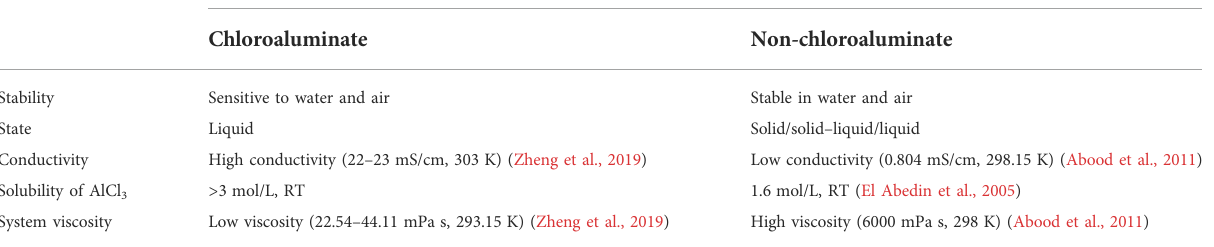
TABLE 1 Performance of different types of ionic